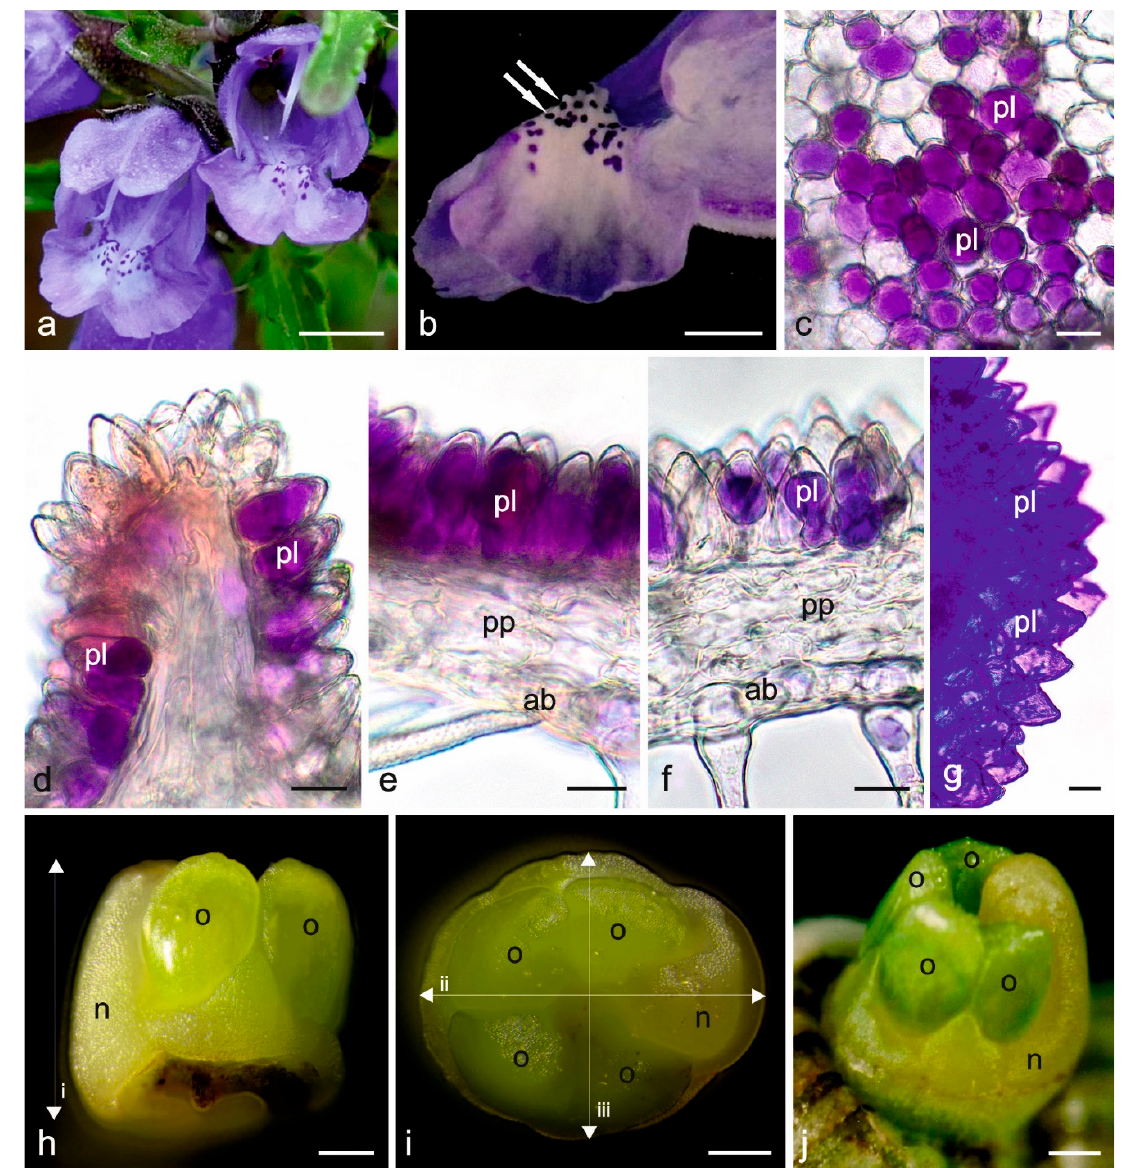
Figure 1. Dracocephalum moldavica flowers and their fragments. ( a ) Part of the inflorescence; ( b ) Flower guides (white double arrow) on the lower lip of the flower; ( c ) Epidermal cells (papillae) forming flower guides—top view, fresh flower; ( d ) Some flower guides located on corolla protrusions—cross-section, fresh flower; ( e ) Cross-section of the lower lip with papillae forming a flower guide—fresh flower; ( f ) Cross-section of the corolla at the flower guide margins, anthocyanin-stained vacuoles in epidermal cells—fresh flower; ( g ) Papillae on the surface of the lower lip stained with Nile blue; ( h – j ) Four-lobed ovaries and annular nectaries collected from fresh flowers: ( h , i )— closed bud stage, ( j )—anthesis stage; pl—papillae; pp—petal parenchyma; ab—abaxial epidermis; n— nectary; o—ovary; i—height of the longer nectary lobe; ii—longer diameter of the nectary; iii—shorter diameter of the nectary. Scale bars: 500 μ m ( a ), 200 μ m ( b , h – j ), 20 μ m ( c – g ) .